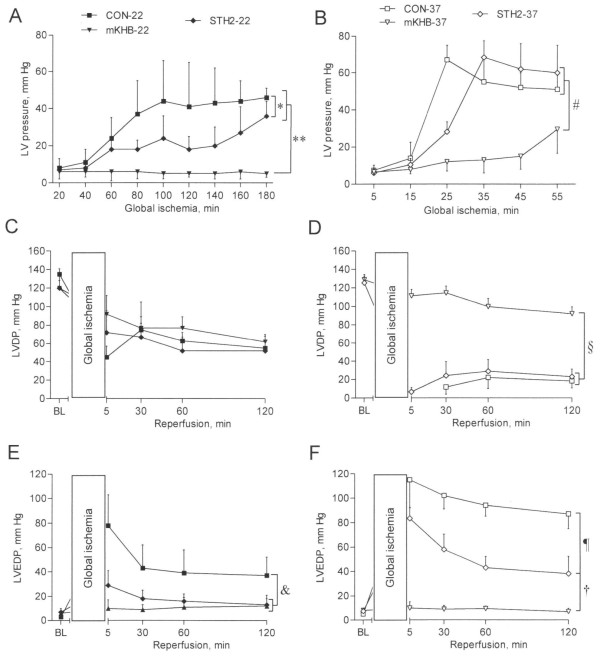
Hemodynamic parameters in the isolated rat hearts subjected to global ischemia under either a hypothermic or normothermic condition (22°C or 37°C, respectively) followed by 120 min of normothermic reperfusion. Ischemic contracture in the hypothermia (A) and normothermia series (B); left ventricular developed pressure (LVDP) in the hypothermia (C) and normothermia series (D); and left ventricular end-diastolic pressure (LVEDP) in the hypothermia (E) and normothermia series (F). Group legends in the hypothermia series: the controls subjected to 180-min ischemia and 120-min reperfusion (CON-22), cardioplegia with the modified Krebs-Henseleit buffer-based cardioplegic solution (mKHB-22), and cardioplegia with St. Thomas’ Hospital cardioplegic solution No. 2 (STH2-22). Group legends in the normothermia series: controls subjected to 60-min ischemia and 120-min reperfusion (CON-37), cardioplegia with the modified Krebs-Henseleit buffer-based cardioplegic solution (mKHB-37), and cardioplegia with St. Thomas’ Hospital cardioplegic solution No. 2 (STH2-37). BL, baseline values. The data are the mean ± SD values. *P < 0.01; **P < 0.001; &P < 0.05; #P < 0.001; §P < 0.0001; ¶P < 0.0001; †P < 0.001.